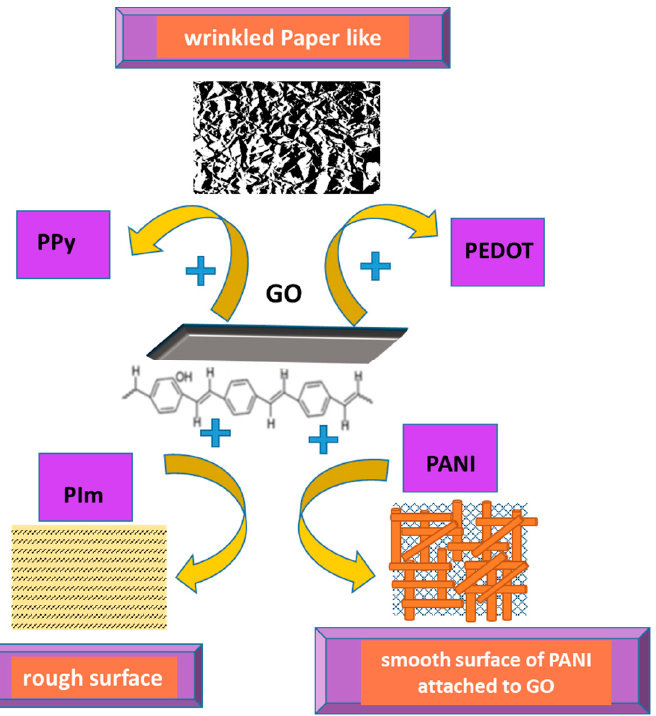
Figure 8. Different surface morphology of CP/GO composites, depending on the CP structure.